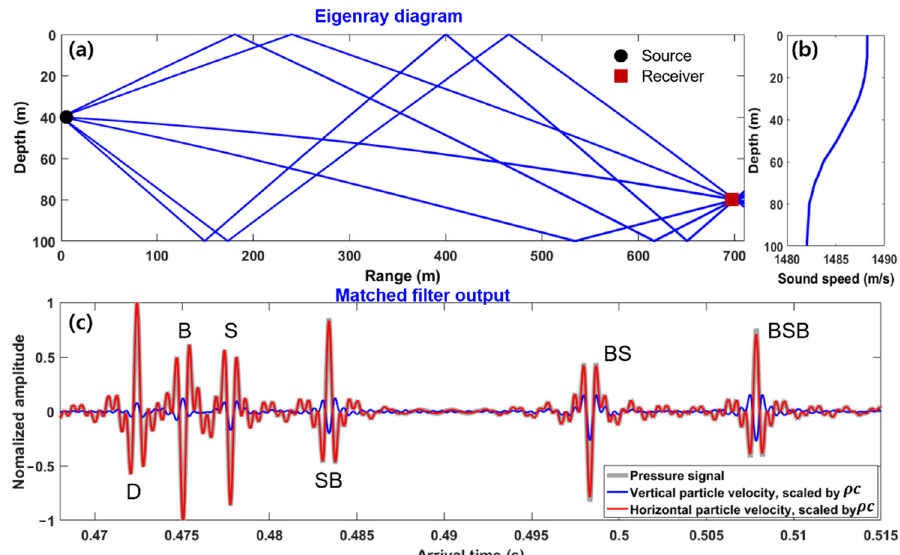
Figure 2. ( a ) Six eigenrays: direct (D), bottom (B), sea surface (S), surface–bottom (S–B), bottom–surface (B–S), and bottom–surface–bottom (B–S–B) paths, in this order, based on ( b ) the water sound speed profile. ( c ) Matched–filtered outputs of acoustic pressure and horizontal and vertical components of particle velocity scaled by acoustic impedance ρ c , where ρ is water density and c is water sound speed.